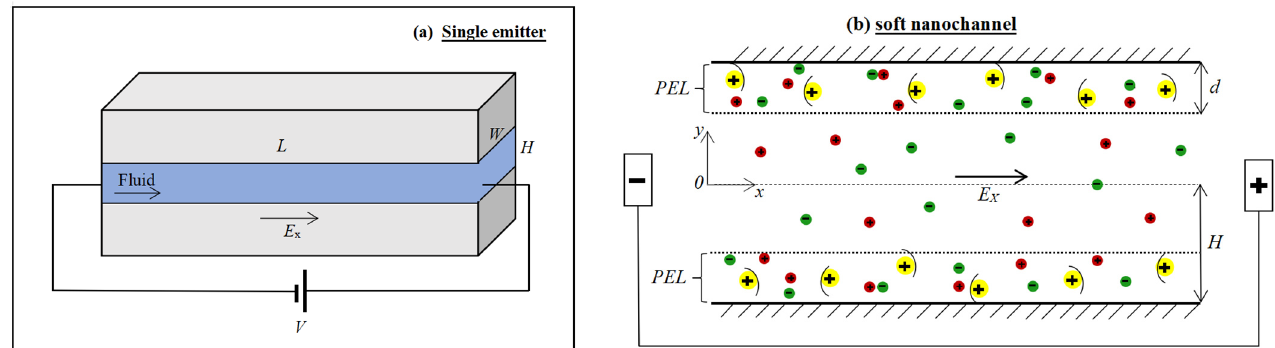
Figure 1. Schematics of ( a ) the single electrokinetic thruster emitter and ( b ) the soft nanochannel with three different kinds of ions, namely cations (red), anions (green) and FCL ions (yellow).